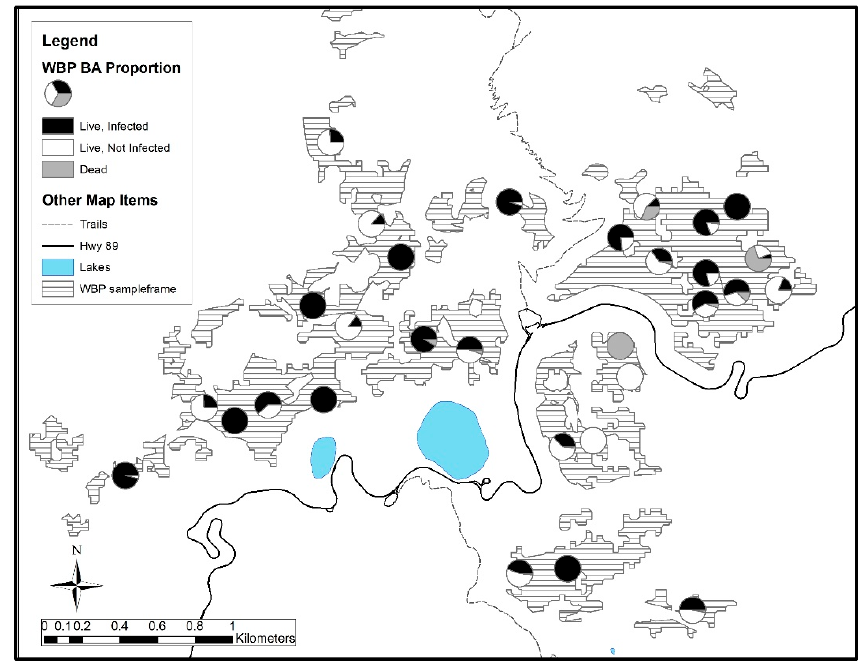
Figure 3. The whitebark pine sampling frame from Lassen Volcanic National Park. Circular symbols show the 30 plots installed between 2012 and 2014, and each symbol is divided into the basal area of whitebark pine that is live, infected with blister rust ( black ), live, not infected with blister rust ( white ), and dead.